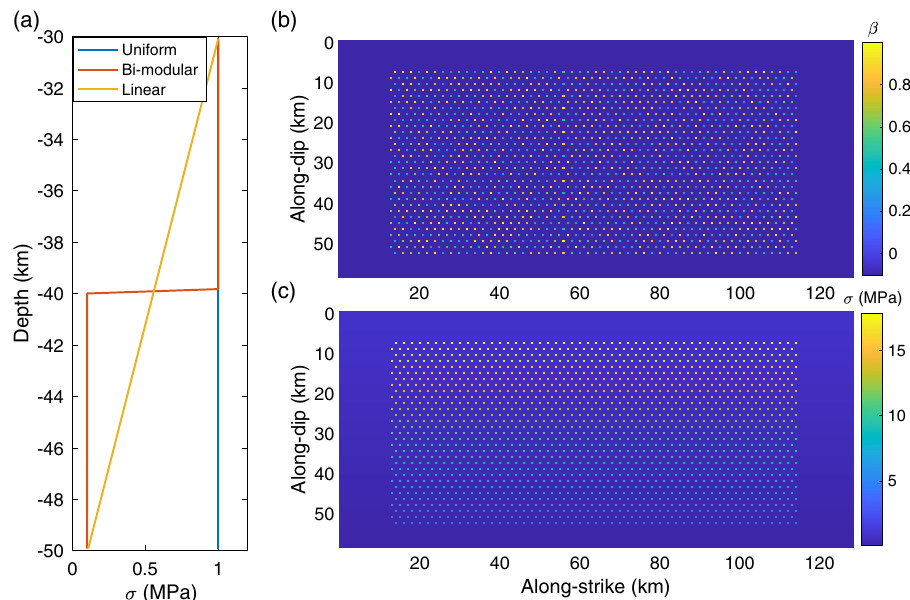
Fig. 4 Rate-and-state model setup. a The along-depth pro fi le of effective normal stress ( σ ) of the background matrix for three end-member models considered: uniform model (blue), bi-modular model (red), and linear model (yellow). b Fault normal view of asperity criticalness β ¼ L asp = L c (asperity size / critical length). c Effective normal stress σ in the linear